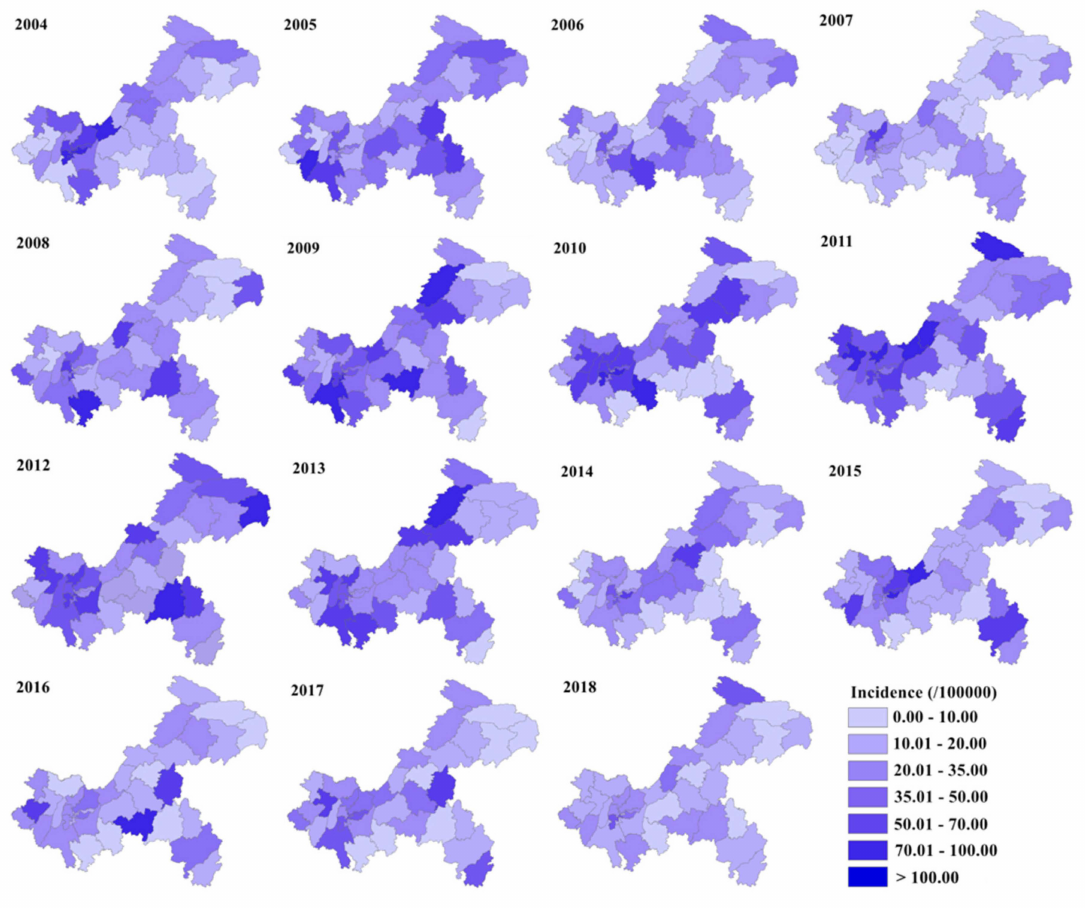
Figure 3. Annual incidence maps of mumps in Chongqing from 2004 to